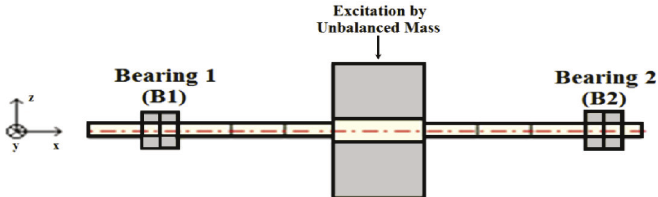
Figure 10 - Finite element model of the rotor used on the test